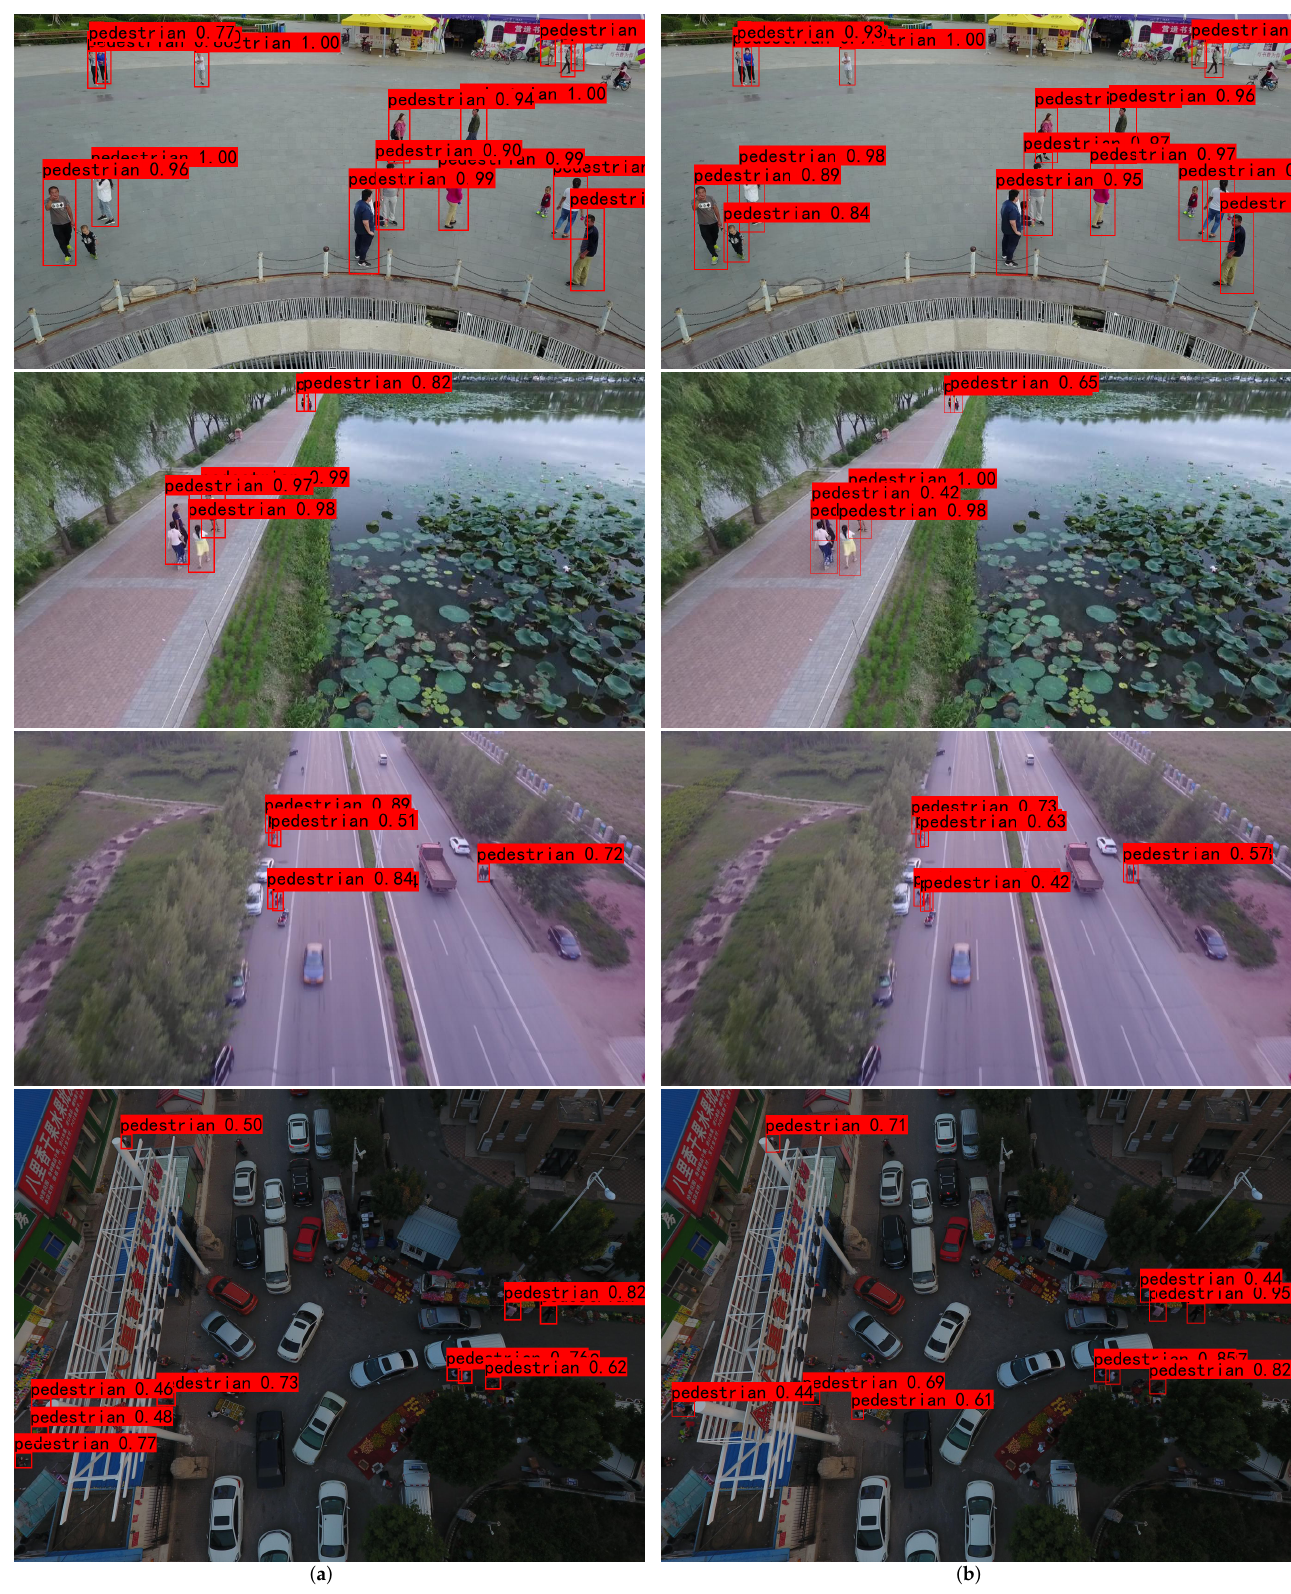
Figure 8. Comparison of the detection results of SMYOLO without scale matching and after scale matching. ( a ) Before scale-match. ( b ) After